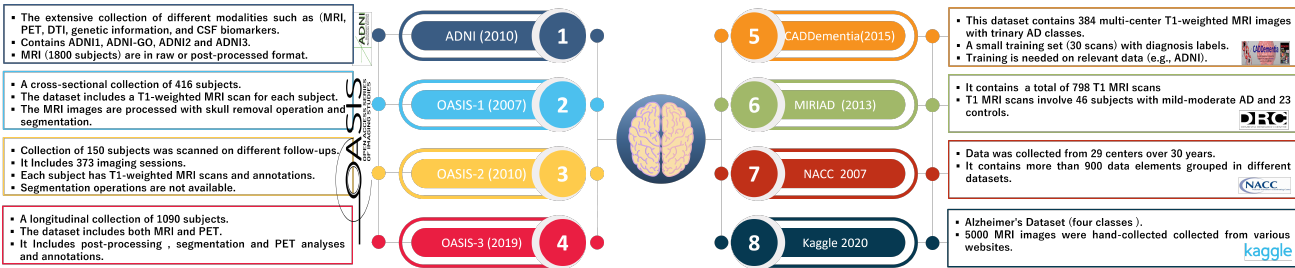
Figure 3. The characteristics of well-known AD